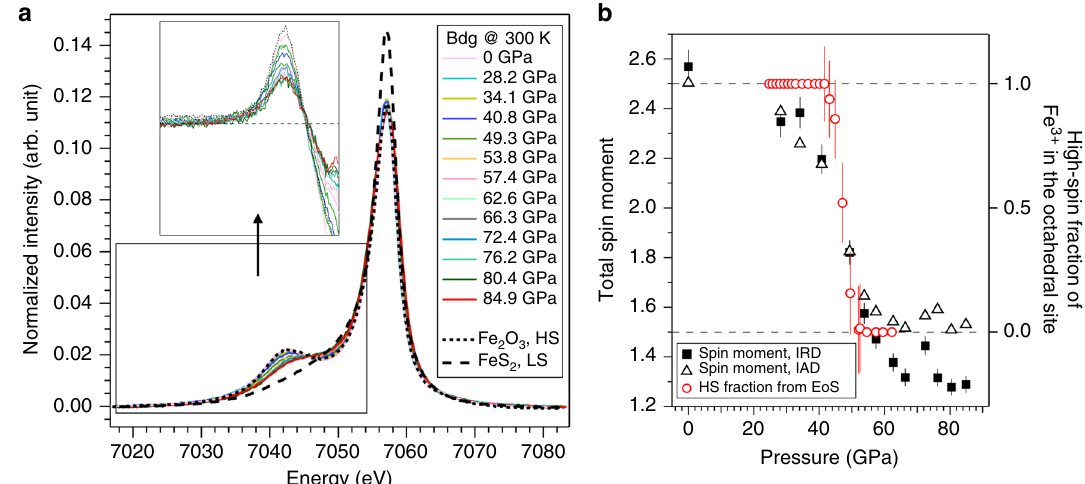
Fig. 3 X-ray emission Fe K β spectra and total spin moment. a XES data for (Mg 0.46 Fe 3 + 0.53 )(Si 0.49 Fe 3 + 0.51 )O 3 bridgmanite up to 84.9 GPa at 300 K. All spectra were normalized to area and aligned to position of the main peak. Both the spectra of Fe 2 O 3 and the sample at 1 bar served as the high-spin (HS) reference, while FeS 2 at 1 bar was used as the low-spin (LS) reference. The inset shows the difference between the sample spectra and the LS reference FeS 2 . b The total spin moment (left axis) derived from both integrated absolute difference (IAD, open triangles) and integrated relative difference (IRD, black squares) methods 68 as a function of pressure. Error bars were determined by evaluating the difference in calculated spin moment using either Fe 2 O 3 or ambient Mg 0.46 Fe 3 + 1.04 Si 0.49 O 3 sample as the HS standard. The expected spin moment for HS-only con fi guration is 2.5 (marked by the upper horizontal dashed line), while the B-site spin transition should lower total spin moment to 1.5 (marked by the lower horizontal dashed line). The red open circles are HS fractions of B-site Fe 3 + (right axis) derived from equation of state (EoS) under high pressures. Error bars of HS fractions obtained from EoS represent 95% con fi dence interval in EoS parameters V HS, V LS, K HS, and K LS 32 . XES and XRD concur that spin transition of B-site Fe 3 + is centered at 48 – 49 GPa